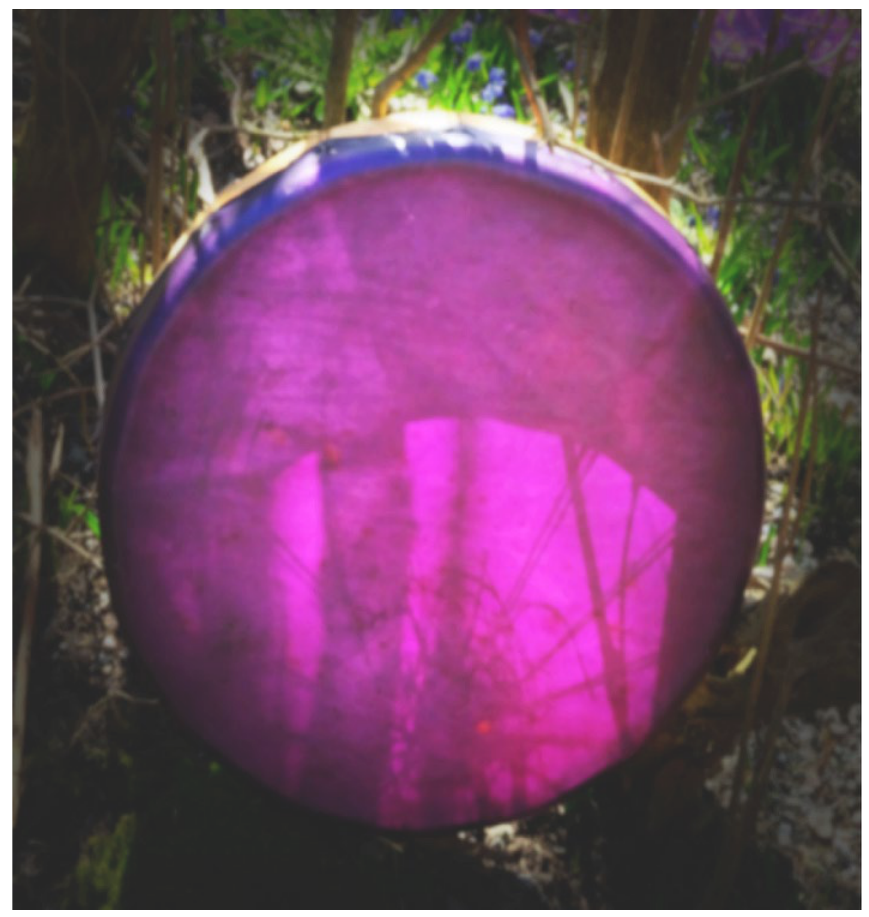
Figure 6 . Entering the circle: transcending